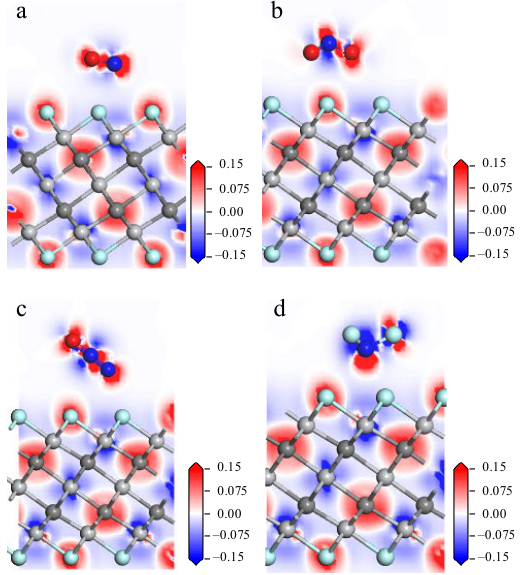
Figure 2. Deformation charge density diagrams of ( a ) NO, ( b ) NO 2 , ( c ) N 2 O, ( d ) NF 3 on Ti 3 C 2 F 2 surface. Table 2. Adsorption energy and charge transfer of gas molecules on Ti 3 C 2 T x.